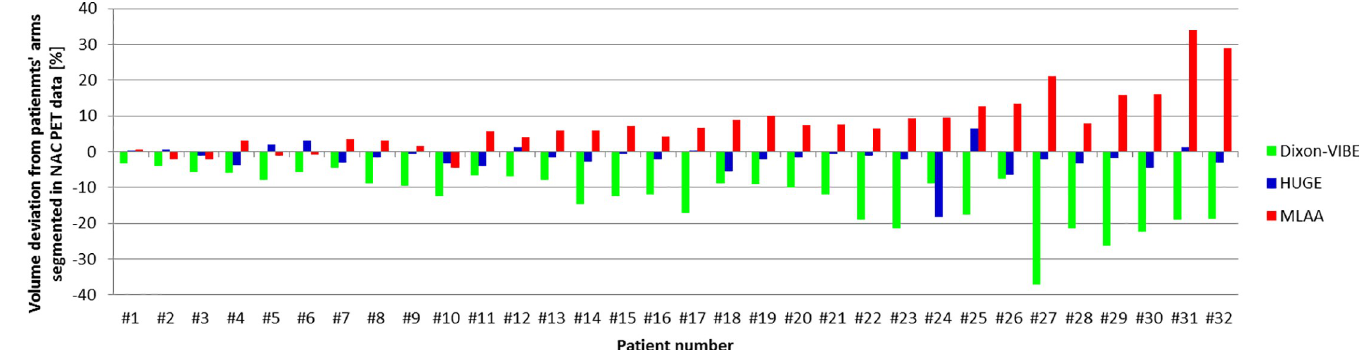
Fig 3. Percentage volume deviations of the patients’ arms compared to the segmented NAC PET images. Percentage volume deviations of the patients’ arms in the Dixon-VIBE, HUGE and MLAA attenuation correction maps compared to the patient’s arms segmented in the non-attenuation corrected (NAC) PET data. All 32 patients are sorted by increasing body mass index (BMI) from left to right. Note the tendency of increased body volume truncation percentage for patients with higher BMI.